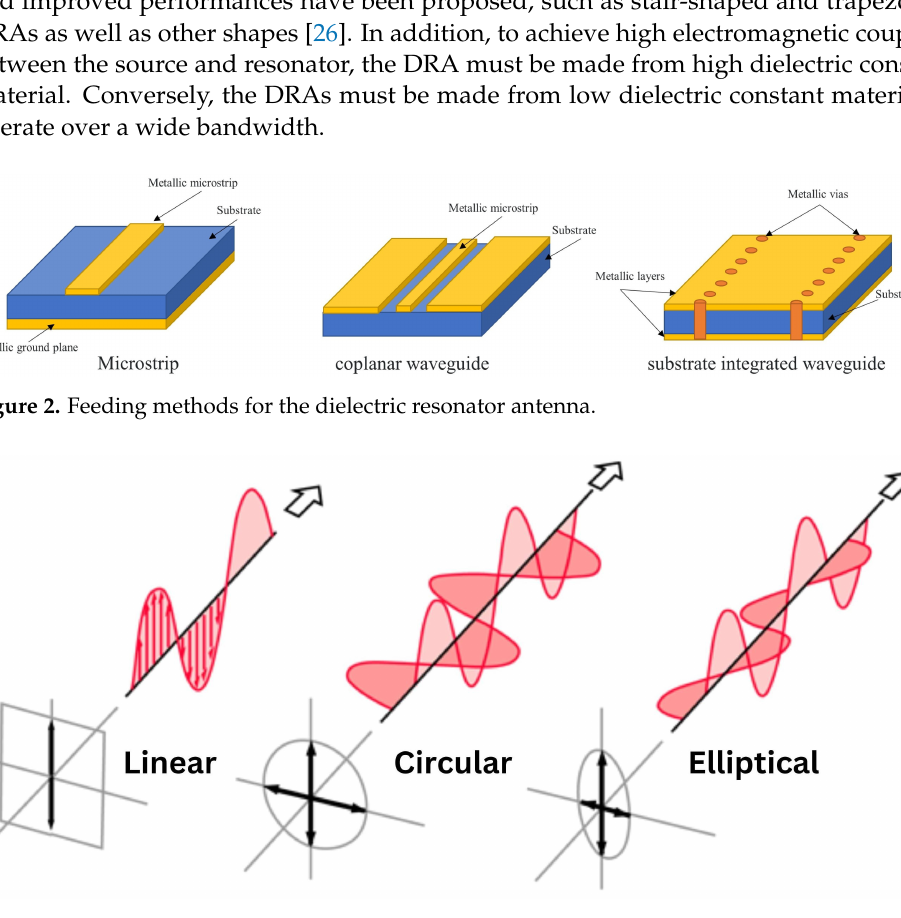
Figure 3. Polarization types